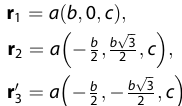
ffiffiffiffiffiffiffiffiffiffiffiffiffiffiffiffiffiffiffiffiffiffiffiffiffiffiffiffiffiffi p ffiffiffiffiffiffiffiffiffiffiffiffiffiffiffiffiffiffiffiffiffiffiffiffiffiffiffiffiffiffi 2 ð 1 (cid:3) cos θ Þ = 3